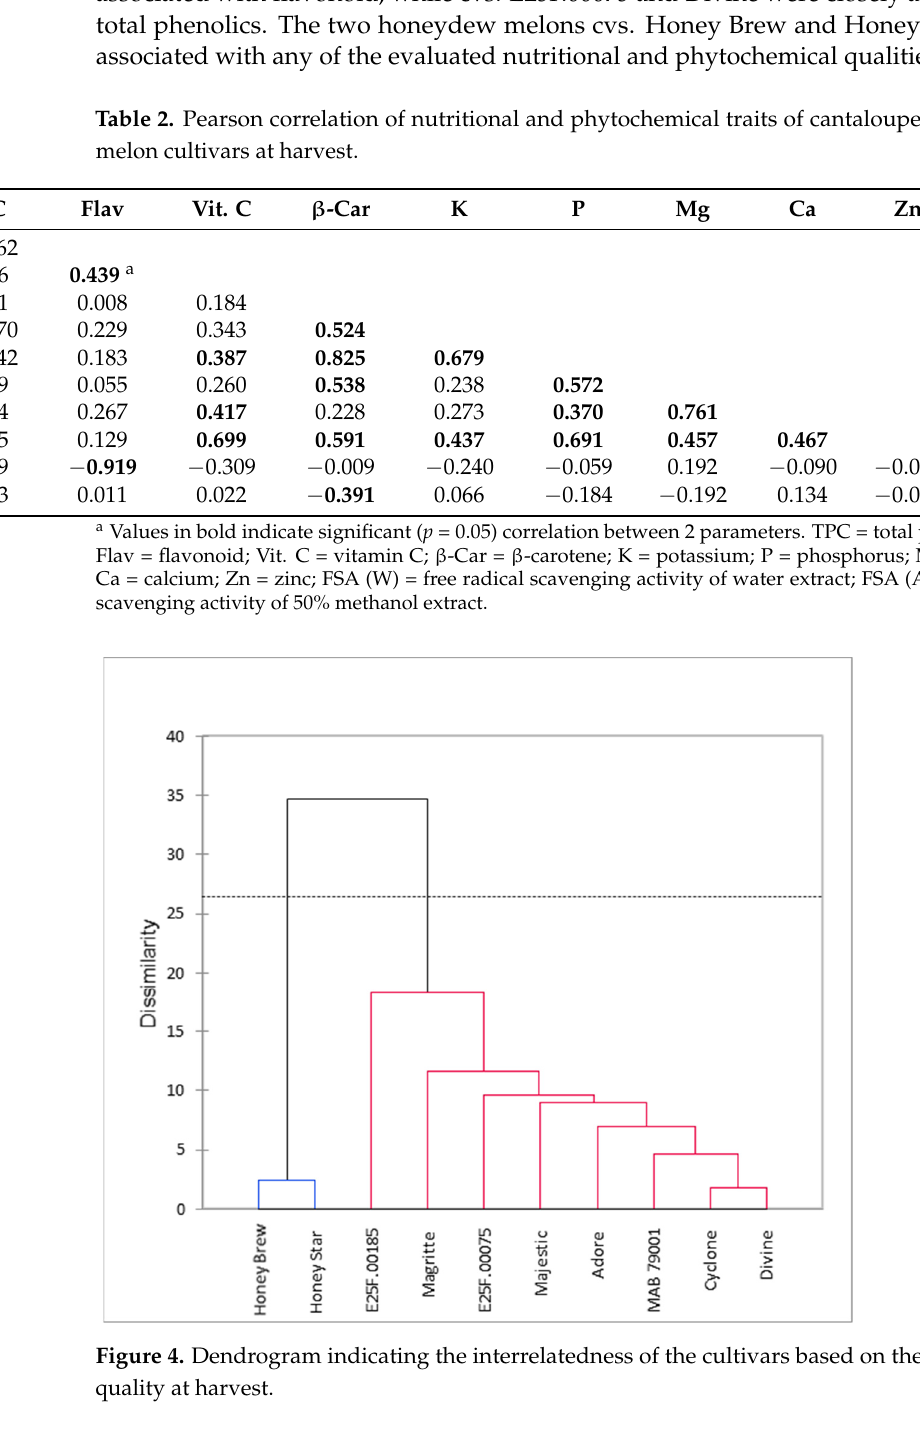
Figure 5. Principal component biplot of fruit nutritional and phytochemical qualities for the evalu- ated honeydew and cantaloupe melon cultivars at harvest. FSA (W) = free radical scavenging activ- ity of water extract; FSA (M) = free radical scavenging activity of 50% methanol extract.